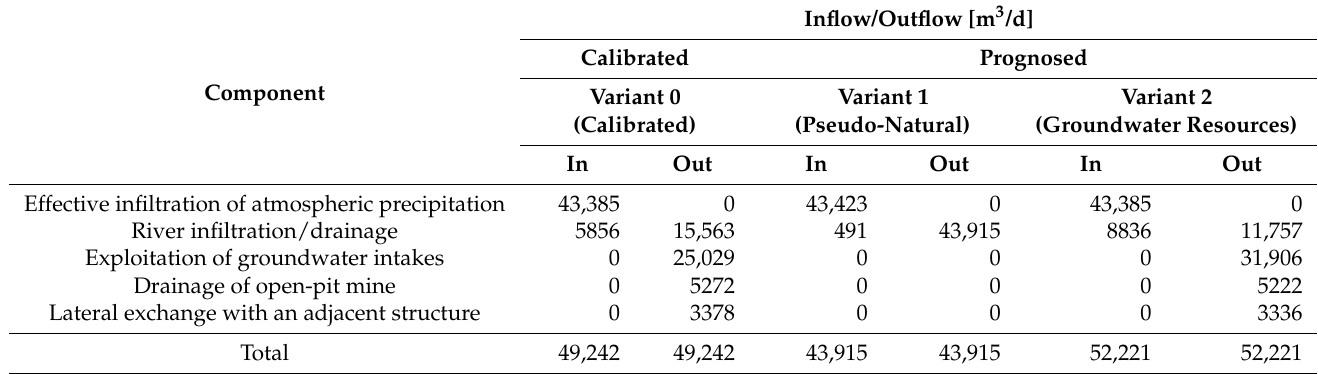
Table 3. Summary of water circulation balance obtained based on model